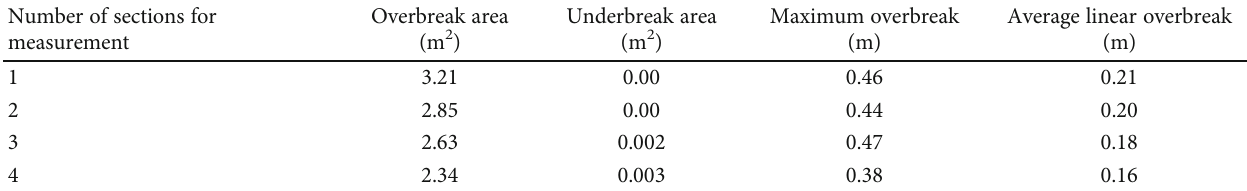
Table 5: Parameter values of tunnel smooth blasting after control implementation.